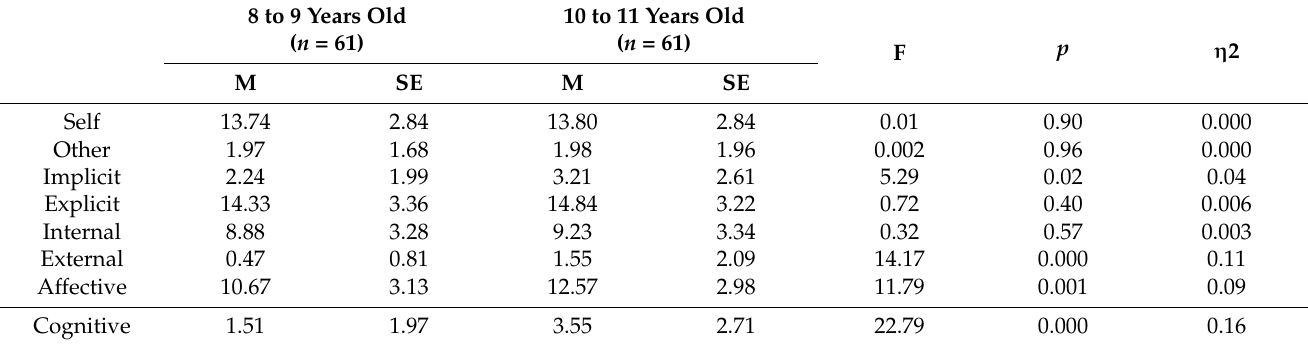
Table 3. Means, Standard Deviations, and Age Group Differences in CRF dimensions.